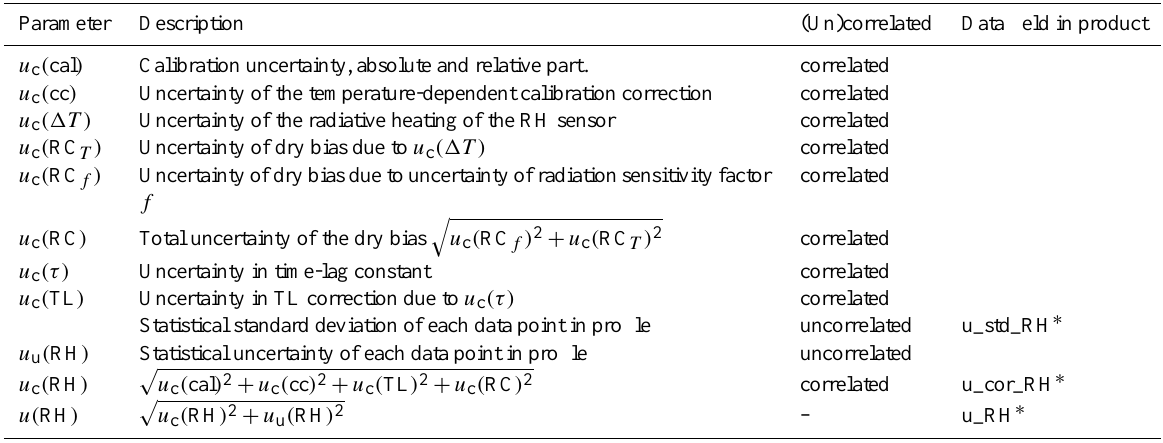
Table 5. Sources of uncertainty for the humidity profile.